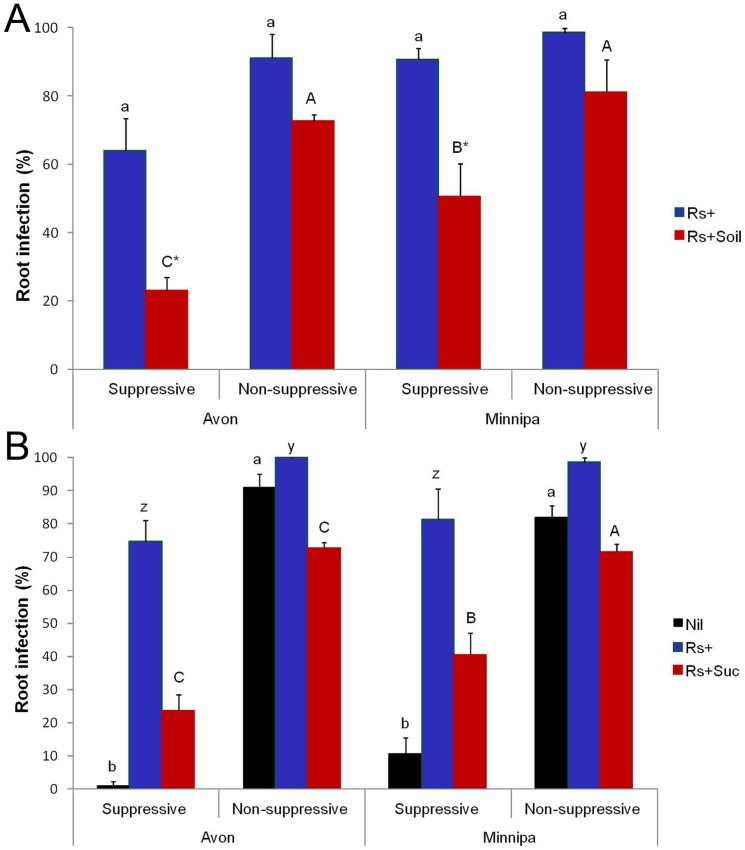
Rhizoctonia disease suppression in wheat seedlings.Results from a 28 day bioassay using soils collected from field sites at the start of the crop season in 2010. Soil transfer bioassay (A); sterile soil with R. solani AG 8 (Rs+, blue) inoculum and sterile soil + R. solani AG 8 (Rs+, red) inoculated with 10% of field soil. Bars of same color with different letters are significantly different at P<0.05 (ANOVA), * indicates significant reduction (P<0.008; ANOVA) in disease with field add soil addition. Disease suppression potential bioassay (B); field soil (Nil, black), field soil with R. solani AG 8 (Rs+, blue) and field soil +C added (Suc) + R. solani AG 8 (Rs+suc, red). Disease suppression potentials – 68.4 & 27.3 Avon soils; 50.1 & 27.6 Minnipa soils. Bars of similar color with different letters are significantly different at P<0.05 (ANOVA).